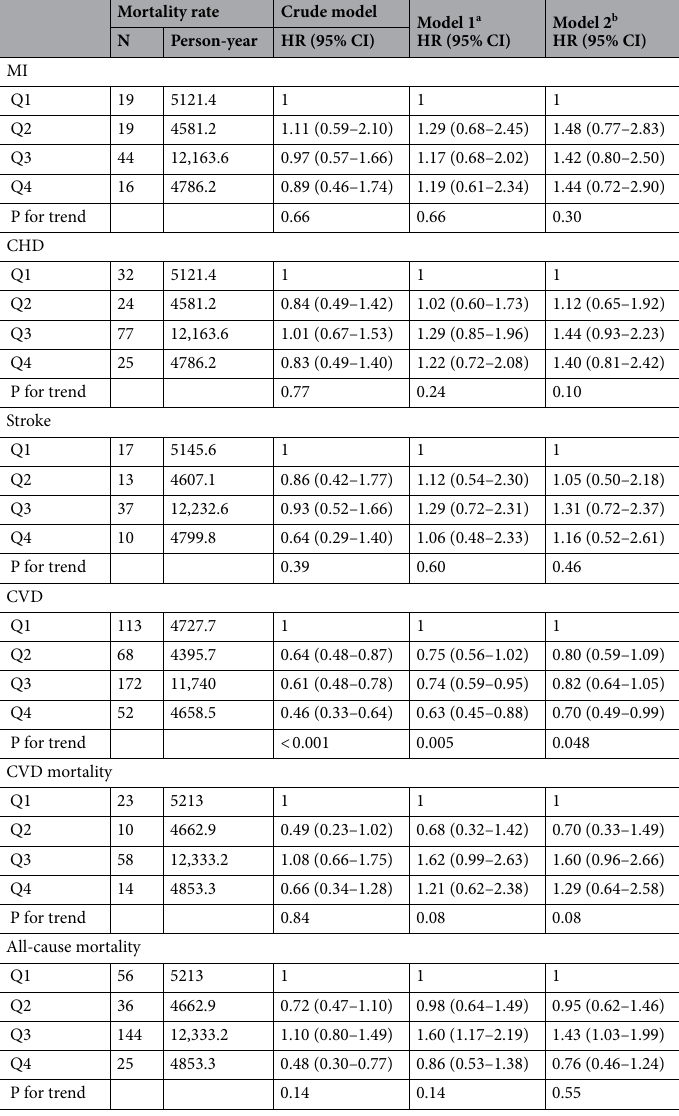
Table 8. Multiple adjusted relative risk of global dietary index in cardiovascular diseases among men. a Adjusted for age (year). b Additionally adjusted for education (illiterate/primary school/more than